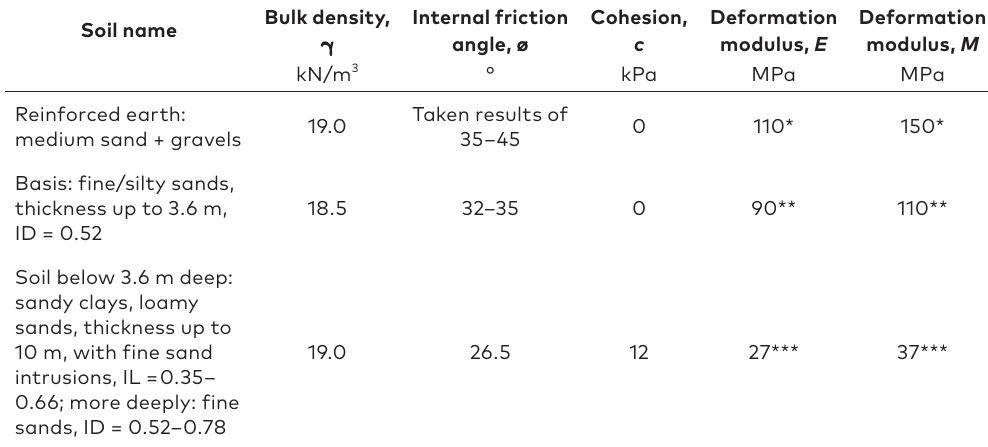
Table 2. Geotechnical parameters of